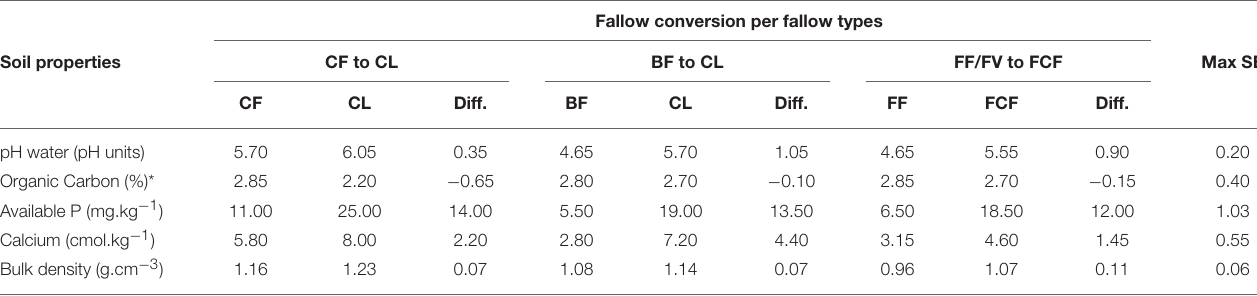
TABLE 2 | Average soil properties change from fallow to food crop fields after burning within the 0–10cm of soil